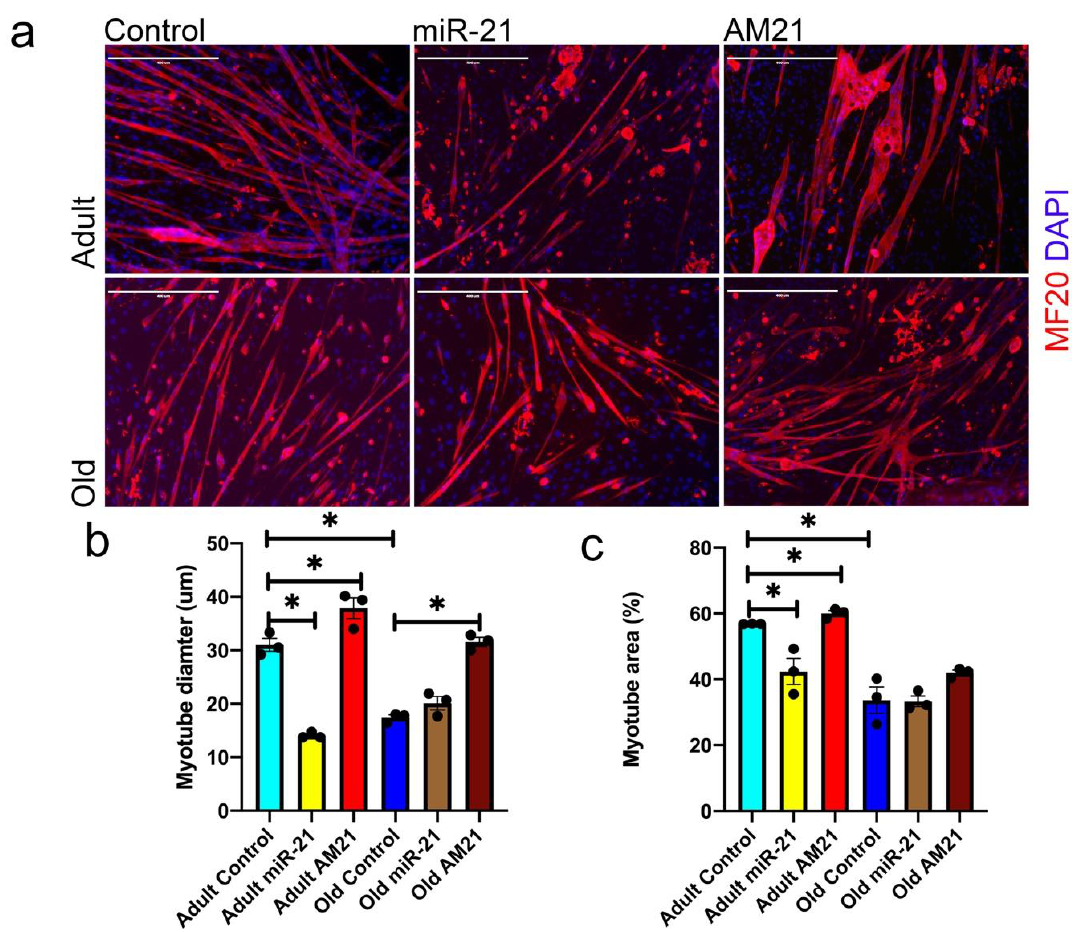
Figure 2. miR-21 negatively regulates myogenic differentiation of satellite cells in vitro. ( a ) Satellite cells migrating out of isolated single myofibers were transfected with miR-21 mimic (miR-21), anti-miR (AM21) or mock-transfected with Lipofectamine 2000 (control: mock-transfected cells); new myotube formation was established by myosin heavy chain immunostaining: MF20—red; DAPI—blue. Quantification of myotube diameter ( b ) and quantification of total myotube area ( c ; as % of the field of view) is shown. Error bars show SEM, • indicates individual replicates *, p < 0.05 (*—compared to adult / old Ctrl, respectively), n = 3. Scale bar = 400 µ